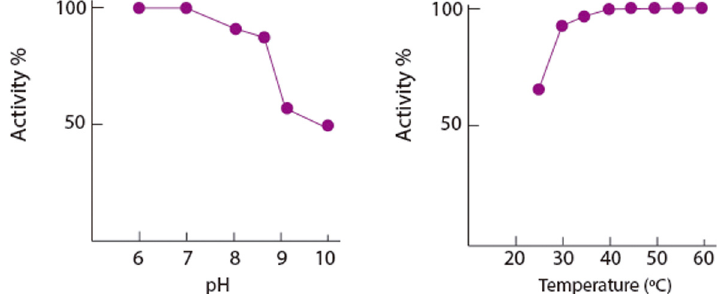
Fig 1. Activity profile at various temperatures and pH for Mv BOD physically adsorbed on SPGE. Sodium phosphate (0.1 M) buffer, pH 7. Electrode set at 600 mV vs.